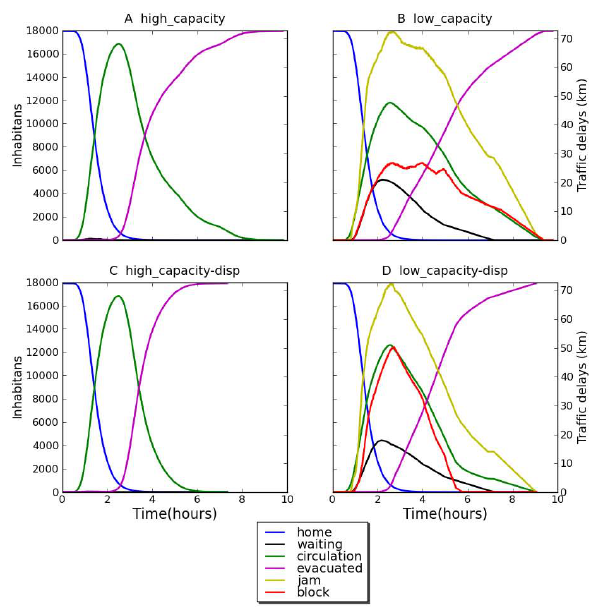
Fig. 13. VSEM results. In all simulations zones, population be- haviour model and speed model are equal. Only two elements have been varied: 1) the road capacity (in the road network point layer) Plots (A) and (C) are simulations with high capacity values while (B) and (D) have low capacity value. The high capacity value rep- resents the use of collective transport (fewer vehicles, no traffic de- lays, etc.); 2) the inhabitants of some localities have been moved to others due to its difficult access the road (track or path). The evac- uation time has been assessed with the entire population within its geographic origin (A) and (B), and displacing the population living in areas of difficult access (C) and (D). (For a better visualization of the results, the reader is referred to the web version of this